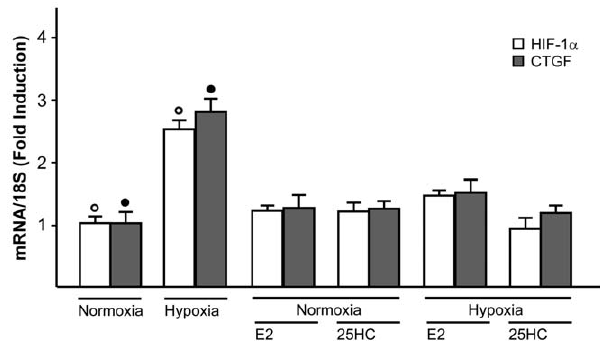
Figure 9. Evaluation of HIF-1 a and CTGF mRNA expression in hypoxic rat heart preparations. HIF-1 a and CTGF mRNA expression was evaluated by real time PCR after 1h exposure to low pO2 levels (40%) and in presence of 1nM E2 or 100nM 25HC treatment, as indicated. mRNA values obtained from control and hypoxic rat hearts were normalized for 18S expression and shown as fold change in triplicate experiments. ( u ), ( N ) indicate p , 0.05 for control versus hypoxic rat hearts.